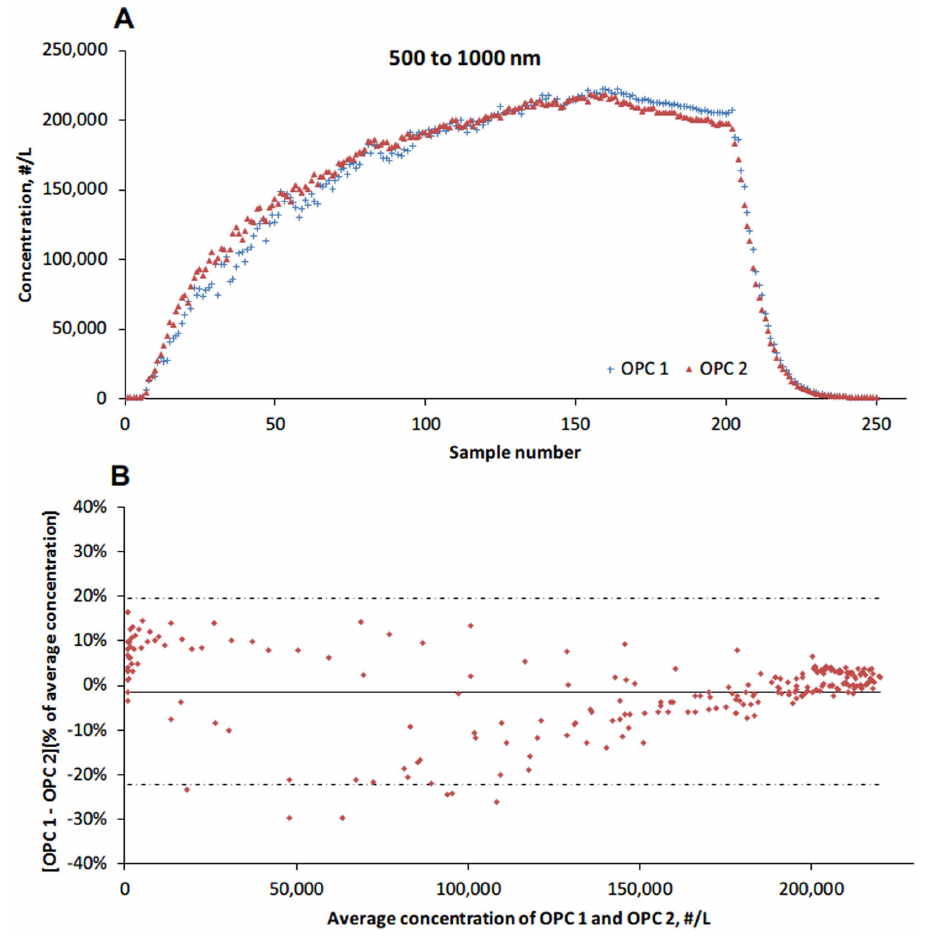
Figure 3. Comparison of 500 to 1000 nm particle measurements by two Optical Particle Counters (OPCs). The solid lines indicate mean percent difference; the dot-dashed lines indicate 6 1.96 standardized deviations (SD) around the mean percent difference.